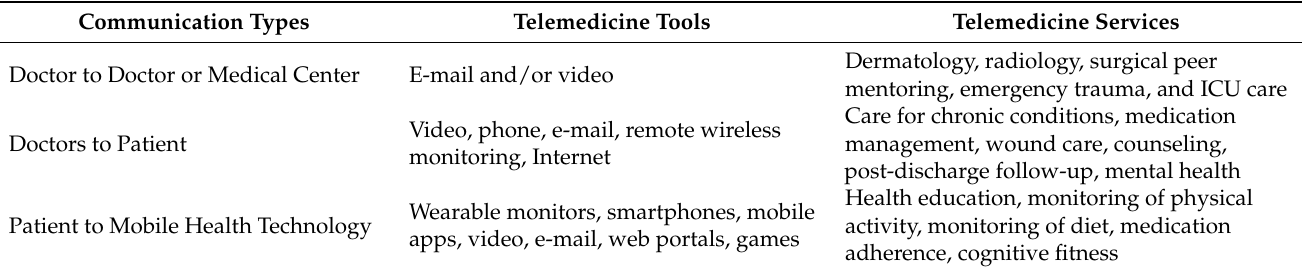
Table 1. Communication types in telemedicine services